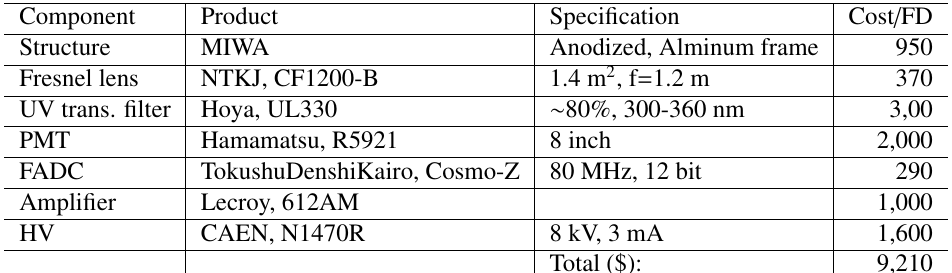
Figure 15. The F.O.V. of each CRAFFT detector is shown as circle drawn over the F.O.V. of the TA FDs edge of which is shown as a solid line [15]. Table 1. The list of the components of CRAFFT detector and each